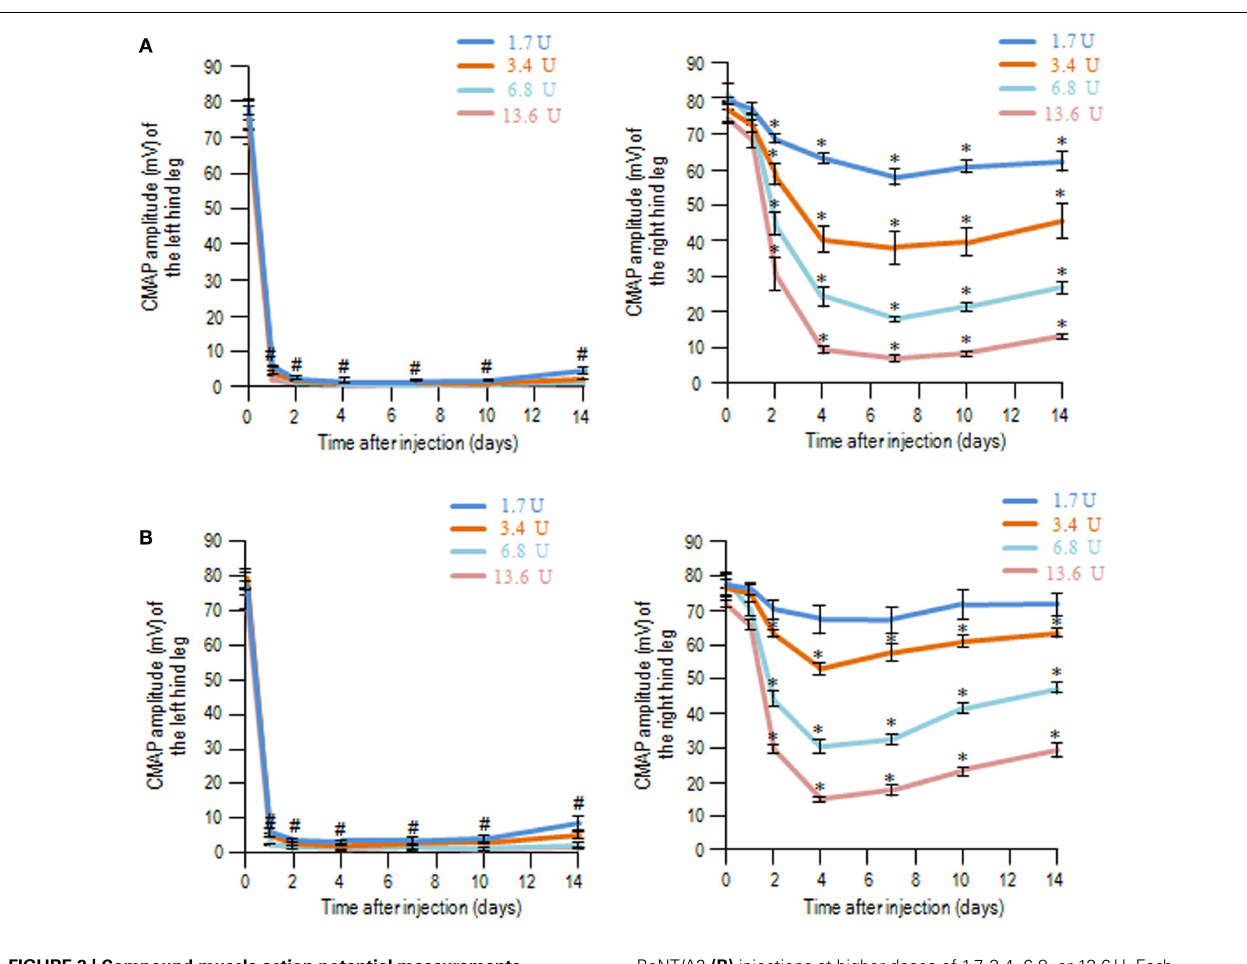
FIGURE 2 | Compound muscle action potential measurements following unilateral intramuscular injection of BoNT/A1 or BoNT/A2 at higher doses .Time-sequential changes in the CMAP amplitudes of left and right hind legs after peripheral BoNT/A1 (A) or